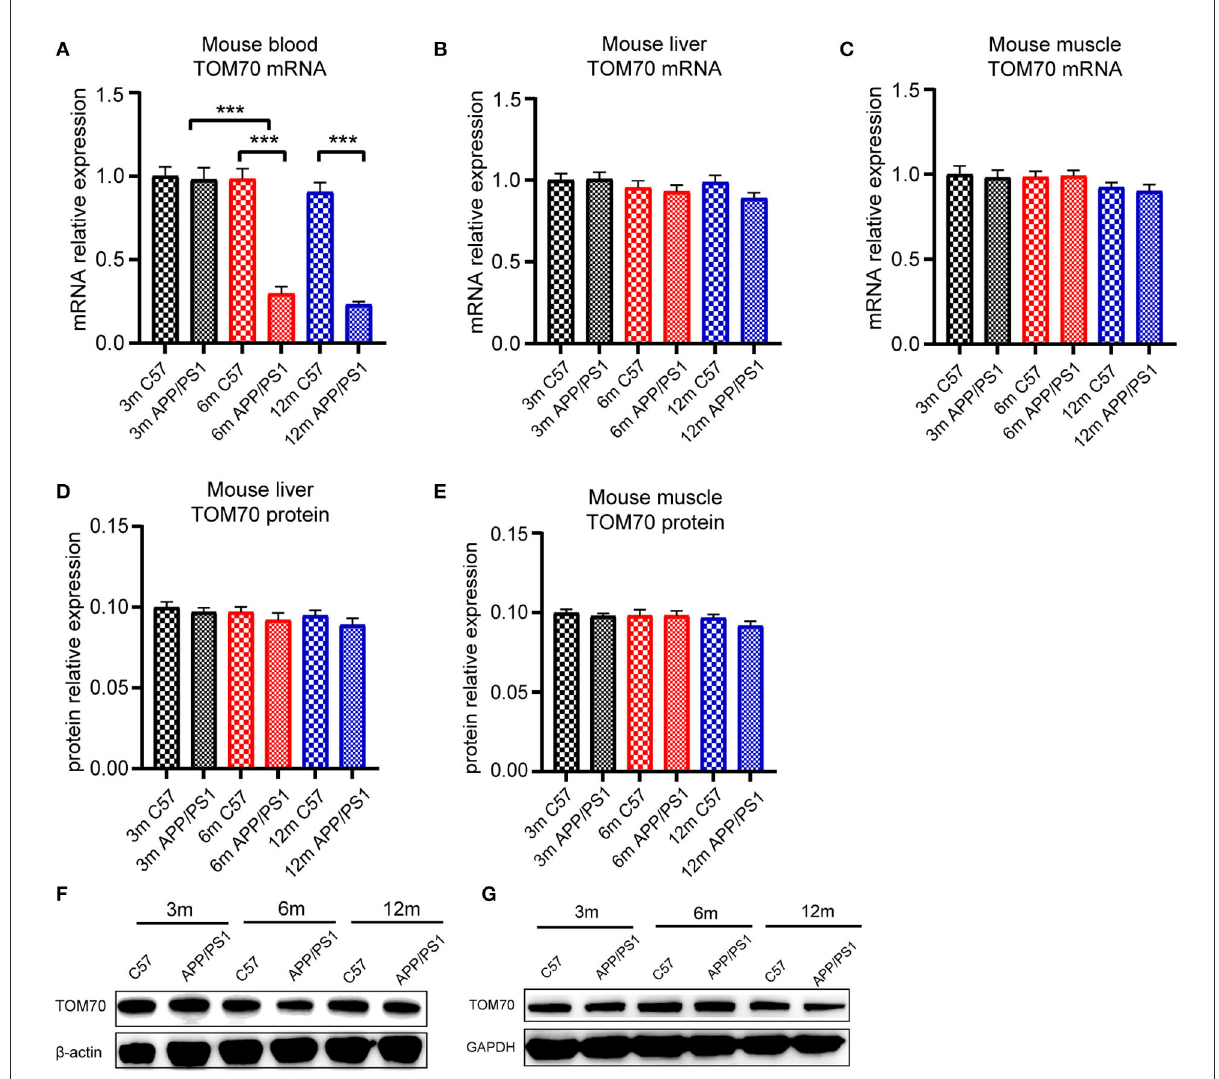
FIGURE6 TOM70 level in mouse peripheral organs. TOM70 levels in mouse peripheral blood, liver, and muscle. TOM70 level was significantly reduced in the blood of APP/PS1 mice at 6 and 12 months. (A) TOM70 mRNA level in the peripheral blood of APP/PS1 and C57 mice aged 3, 6, and 12 months. (B) TOM70 mRNA level in the liver of APP/PS1 and C57 mice aged 3, 6, and 12 months. (C) TOM70 mRNA level in the skeletal muscle of APP/PS1 and C57 mice aged 3, 6, and 12 months. (D) TOM70 protein level in the liver of APP/PS1 and C57 mice aged 3, 6, and 12 months. (E) TOM70 protein level in the skeletal muscle of APP/PS1 and C57 mice aged 3, 6, and 12 months. (F) Representative western blotting bands of mouse liver. (G) Representative western blotting bands of mouse muscle. Unpaired Student’s t- test. n = 6 samples. m = month. Bar graph is expressed as mean ± SEM. *** P <